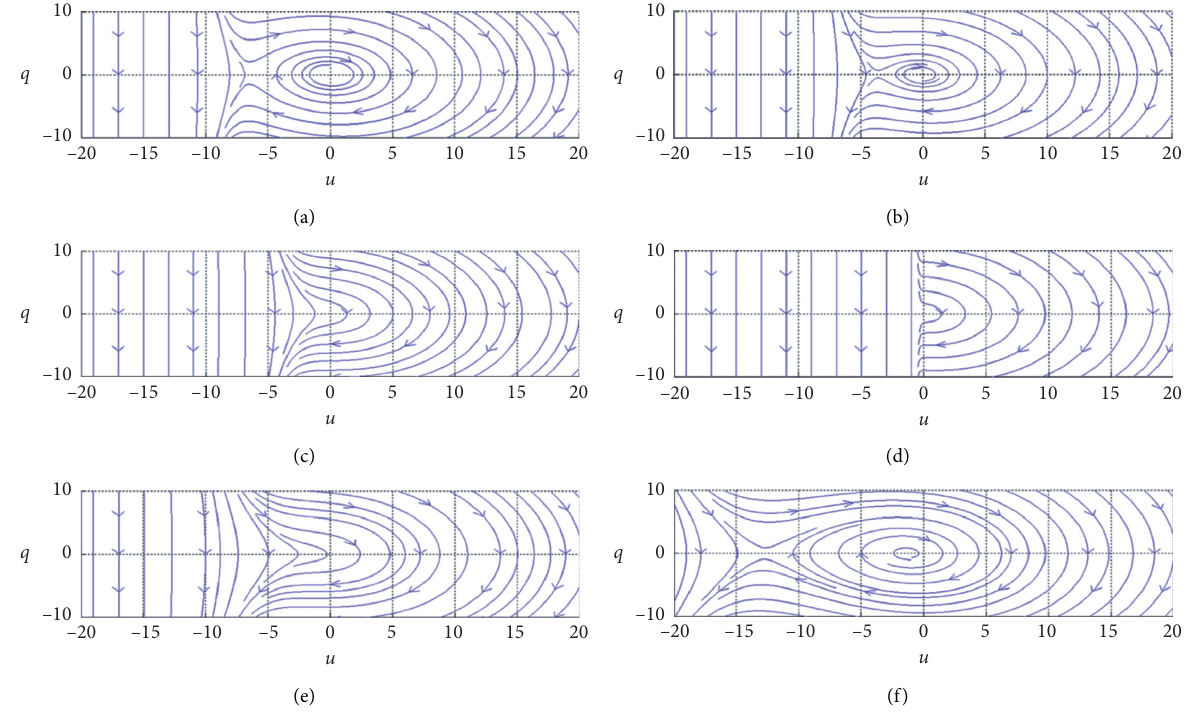
Figure 6: The shock excitation signal in the time